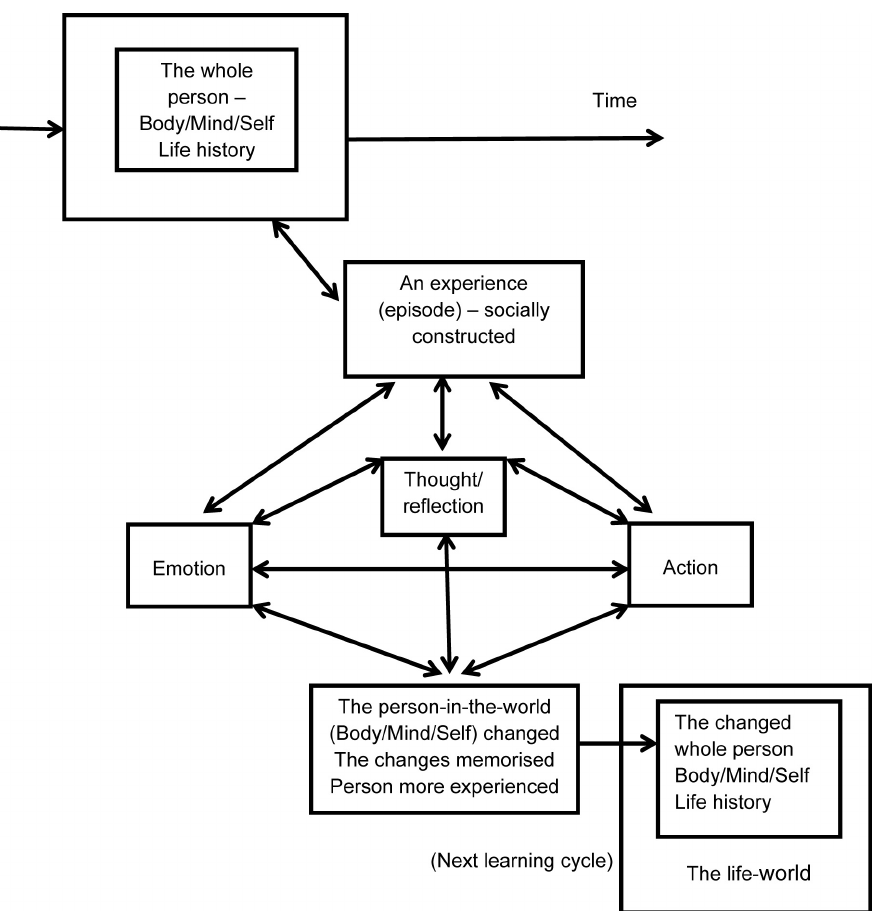
Figure 1: The transformation of the person through experience (Jarvis, 2006: 23)